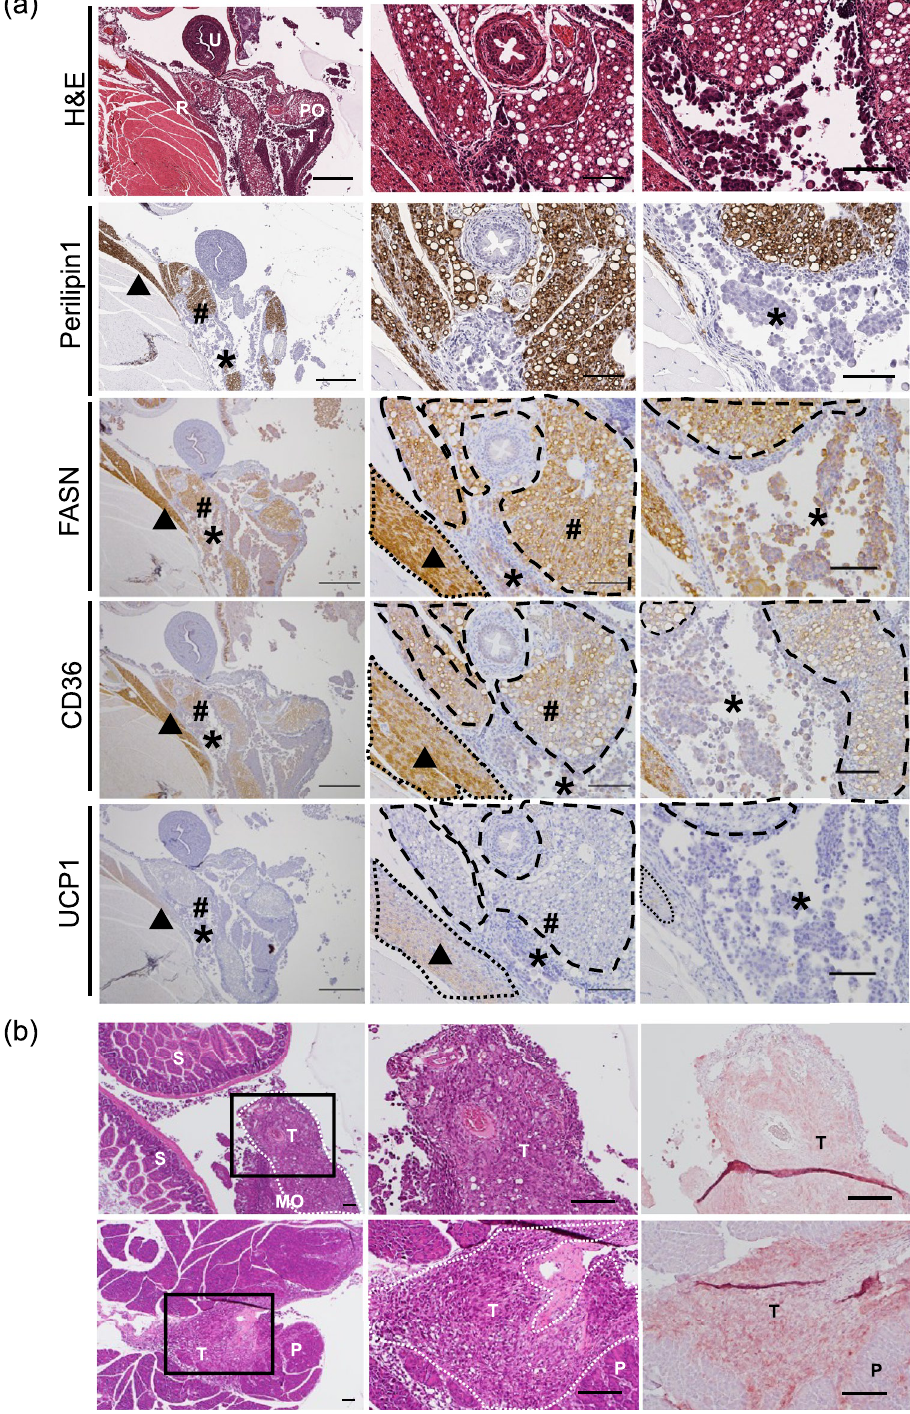
Figure 4. ( a ) Expression of lipid metabolism-related molecules. FASN, CD36, and UCP1 were stained for ES-2-disseminated cancer cells, visceral white adipocytes, and retroperitoneal brown adipocytes. “*” indicates disseminated or floating cancer cells; “#” indicates visceral adipocytes; “ ▲ ” indicates brown adipocytes. The dotted lines indicate brown adipose tissue. The dashed lines indicate white/visceral adipose tissue. T disseminated cancer, U uterus, R retroperitoneal adipose tissue, PO periovarian adipose tissue. Scale bar: 2 mm (left), 500 µm (middle), and 100 µm (right). (b) Staining with hematoxylin and eosin (H&E) (left, middle) and RNA-ISH (right) for disseminated human cancer cells using an anti-human mRNA-positive control probe. T disseminated cancer, S small intestine, MO major omentum, P pancreas. Scale bar: 500